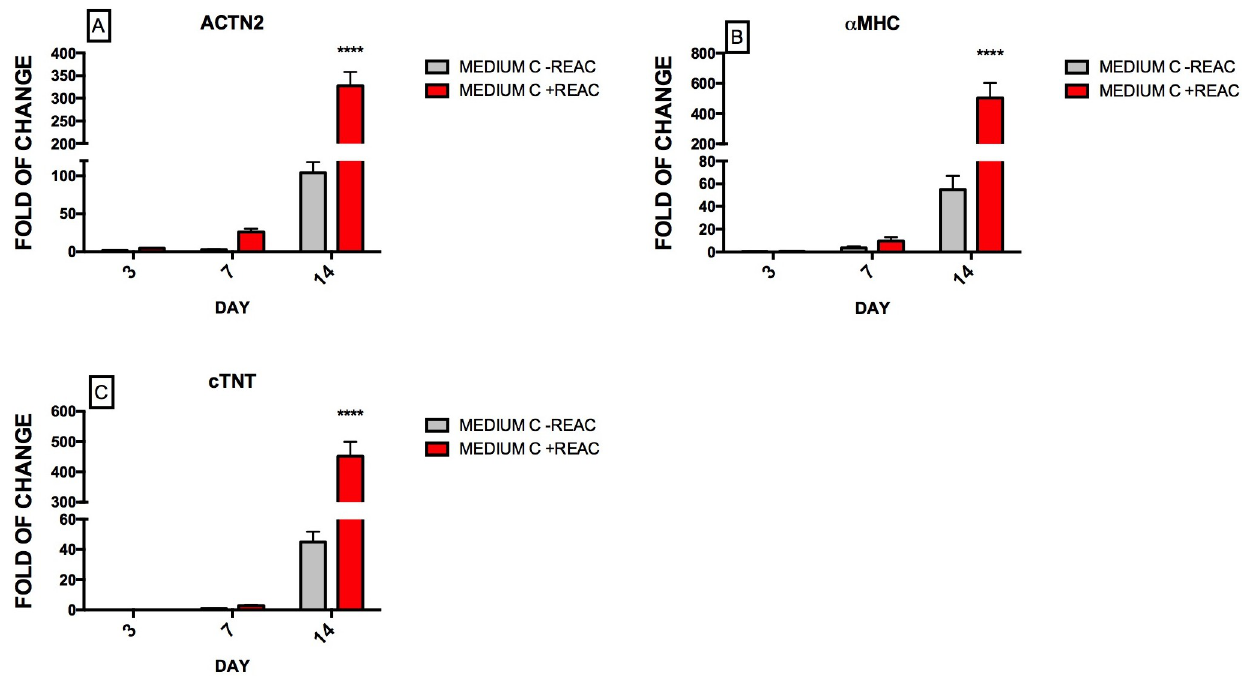
Fig 4. Effect of REAC treatment on the expression of early cardiac-specific marker genes in hUiPSCs supplemented with defined medium. Cells cultured in cardiogenic conditioned medium (Medium C) were exposed for 72 hours, in the absence (grey bars) or presence (red bars) of REAC, and then cultured in the presence of medium C alone until day 14. The amount of ACTN2 (A), α MHC (B), and cTnT (C) mRNA from untreated (grey bars) or REAC- treated (red bars) cells was normalized to glyceraldehyde 3-phosphate dehydrogenase (GAPDH) and was plotted as fold of change relative to the mRNA expression of hUiPSCs at day 0. Data shown mean ± S.D; n = 4 (P < 0.05 �� ), (P < 0.001 � �� ).